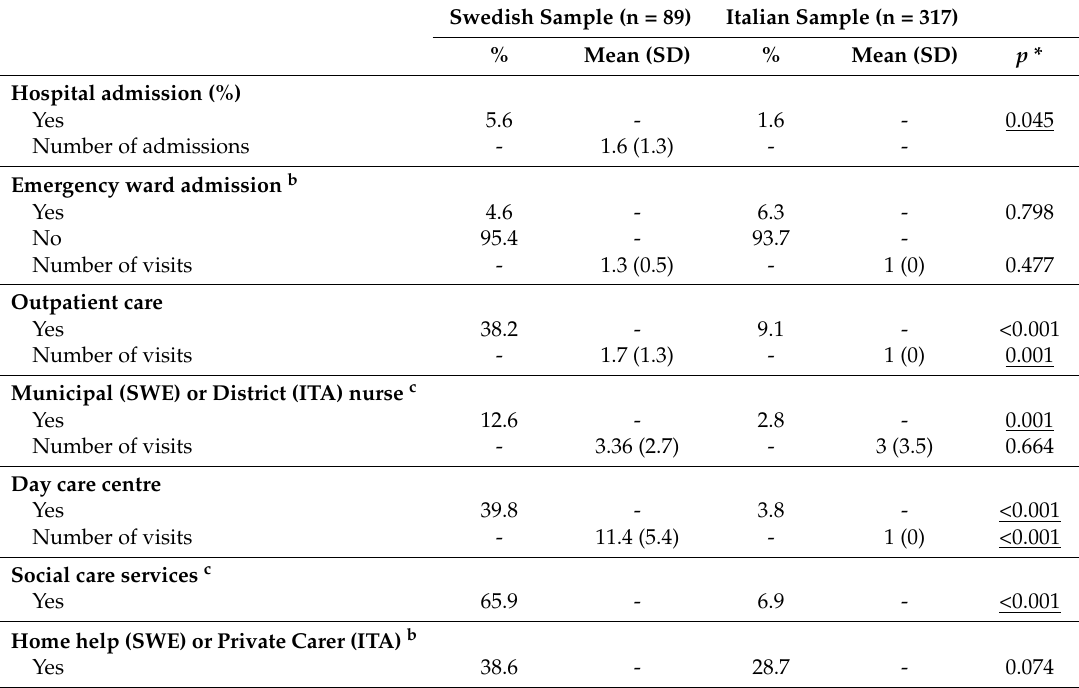
Table 2. Resource utilization the last 30 days of healthcare and social services by persons with dementia.